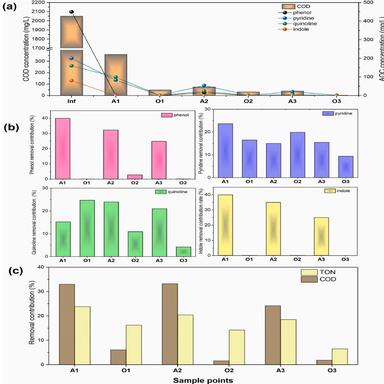
(a) Variations of COD, phenol, quinoline, indole and pyridine concentration profile; (b) phenol, quinoline, indole and pyridine removal contribution in each zone; (c) COD and TON removal contribution in each zone.